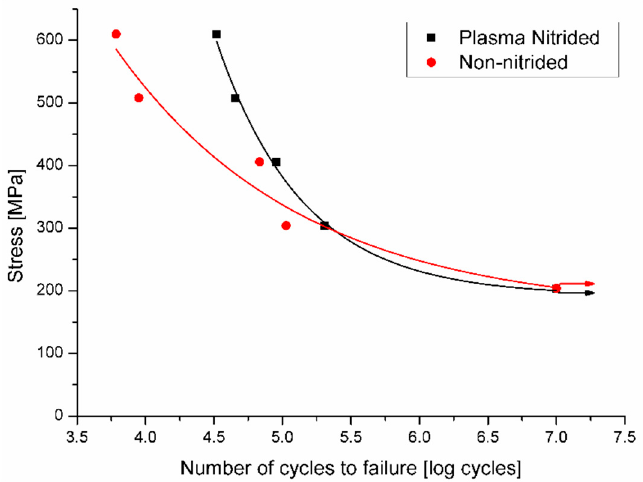
Figure 4. Graphic of stress versus number of cycles obtained from the fatigue tests on the non-nitrided and nitrided Ti-6Al-4V alloy. Arrows indicate samples that did not fail.